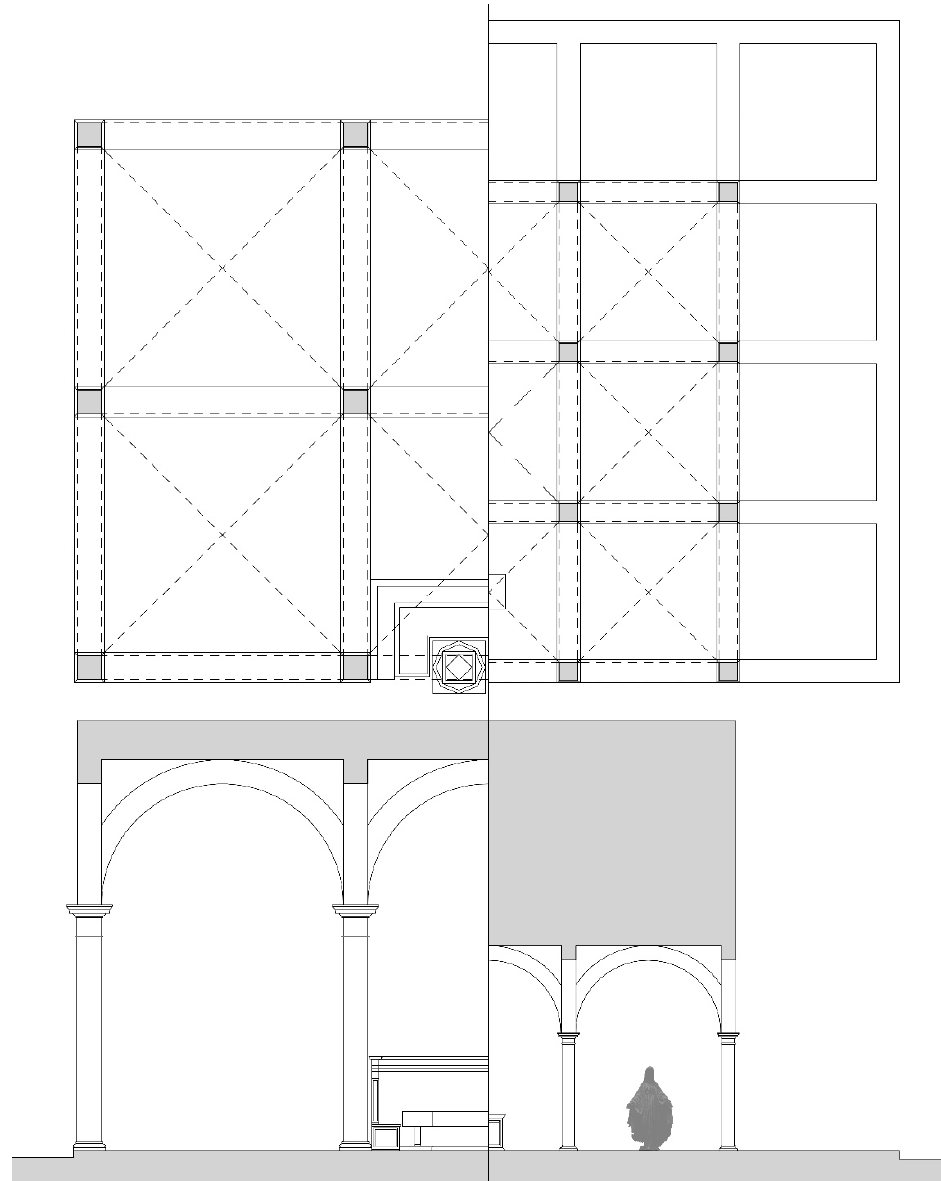
Figure 9. Dimensional comparison between half-plan and half-section from the restitution of Perugino’s Last Supper of St. Onofrio, 1482, and The Annunciation of Fano, 1489.